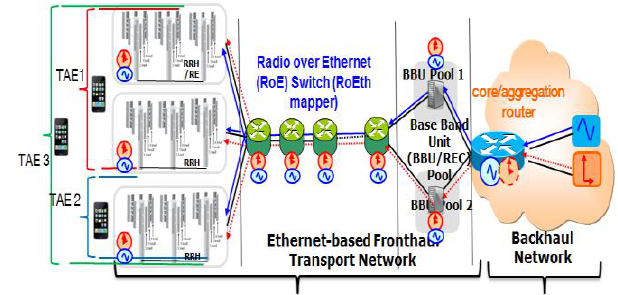
Figure 3. Illustration of transport of frequency and phase/time synchronization over fronthaul network.